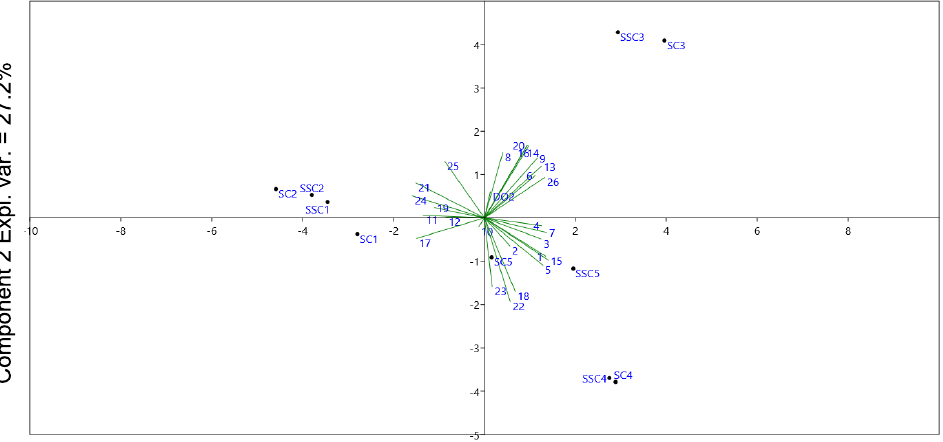
Figure 4. PC1 (exp. variance = 40.8%) vs. PC2 (exp. variance = 27.2%) model for St. Magdalener wines. Volatile compound relative abundances and measured dissolved oxygen were used as variables. Volatile compound labels ( 1 – 26 ) are explained in Table 4.